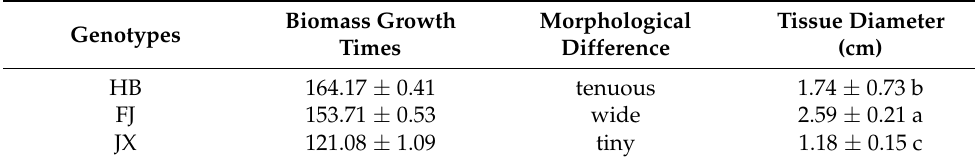
Table 4. Growth status of three genotypic H. serrata .